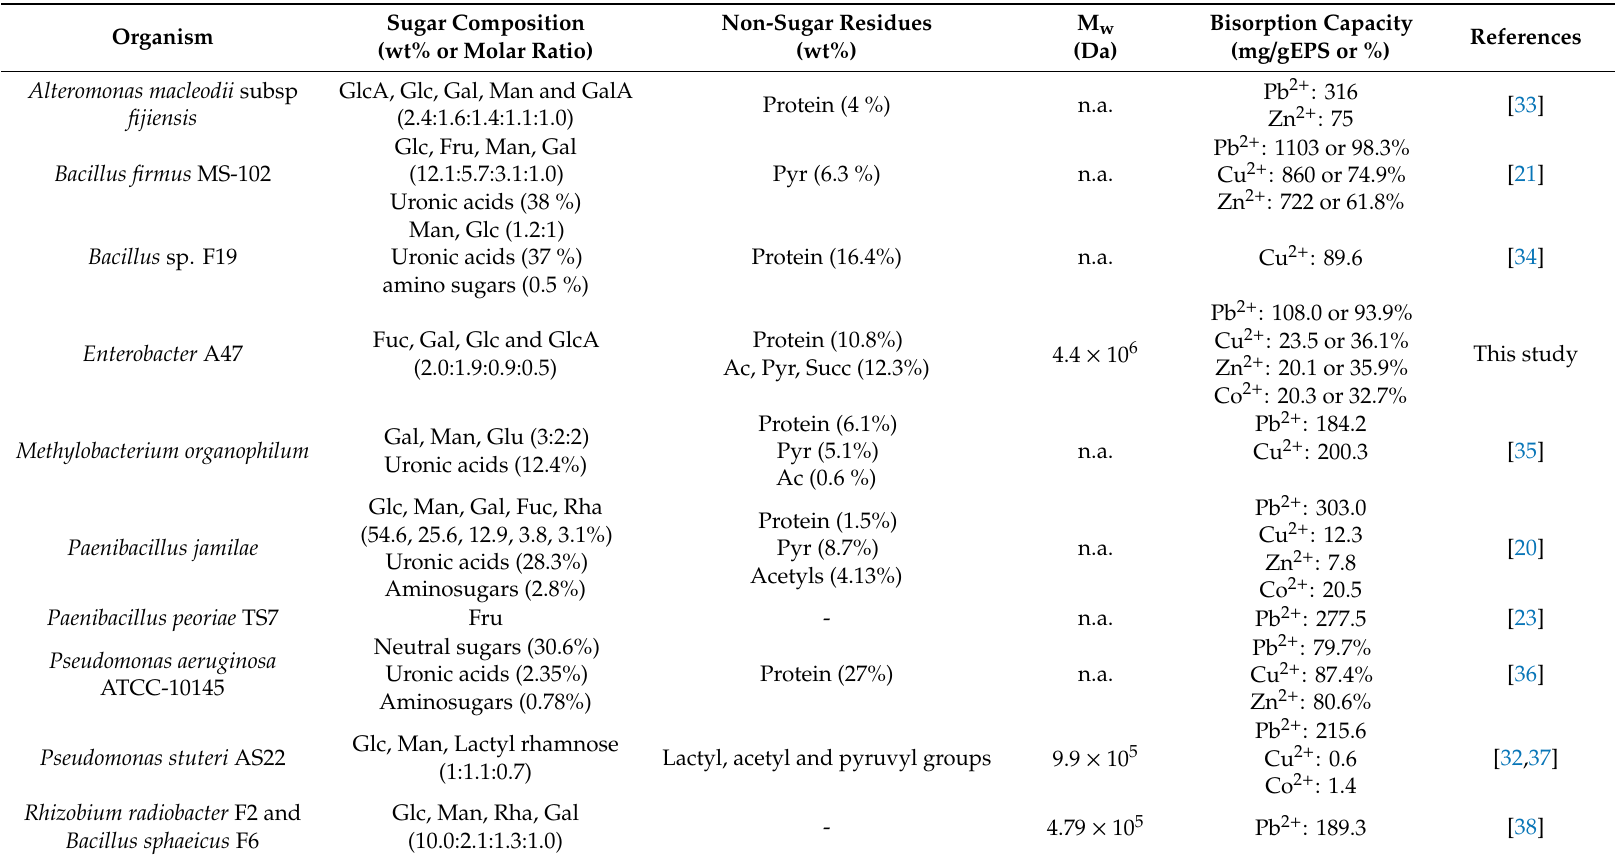
Table 1. Microbial EPS with biosorption capacity towards heavy metals (Man, mannose; Glc, glucose; Gal, galactose; Rha; rhamnose; Fuc, fucose: Fru, fructose; GlcA, glucuronic acid; GalA, galacturonic acid; Pyr, pyruvate; Succ, succinate; Ac,